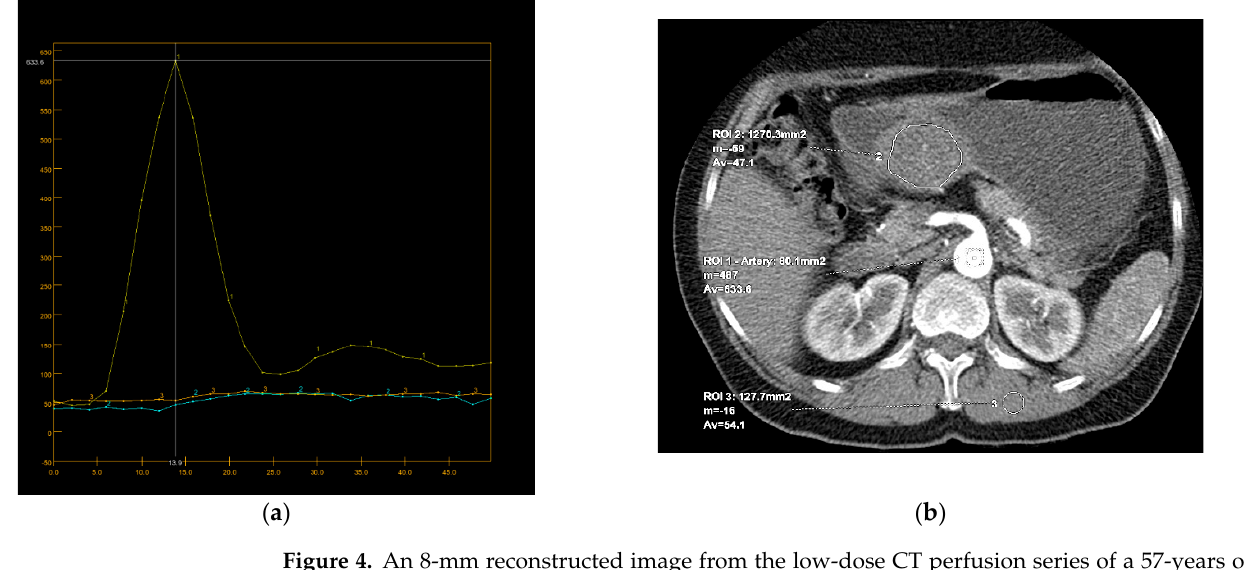
Figure 4. An 8-mm reconstructed image from the low-dose CT perfusion series of a 57-years old female patient with gastric GIST. Time − density curve on computed tomography perfusion ( a ) . The arterial (yellow), tumor (blue), and muscle (orange), time-attenuation curves of the corresponding CT perfusion section. A freehand ROI (this tool measures area in square milimeters ) in the region of tumor and round ROIs in the aorta and paravertebral muscle ( b ).